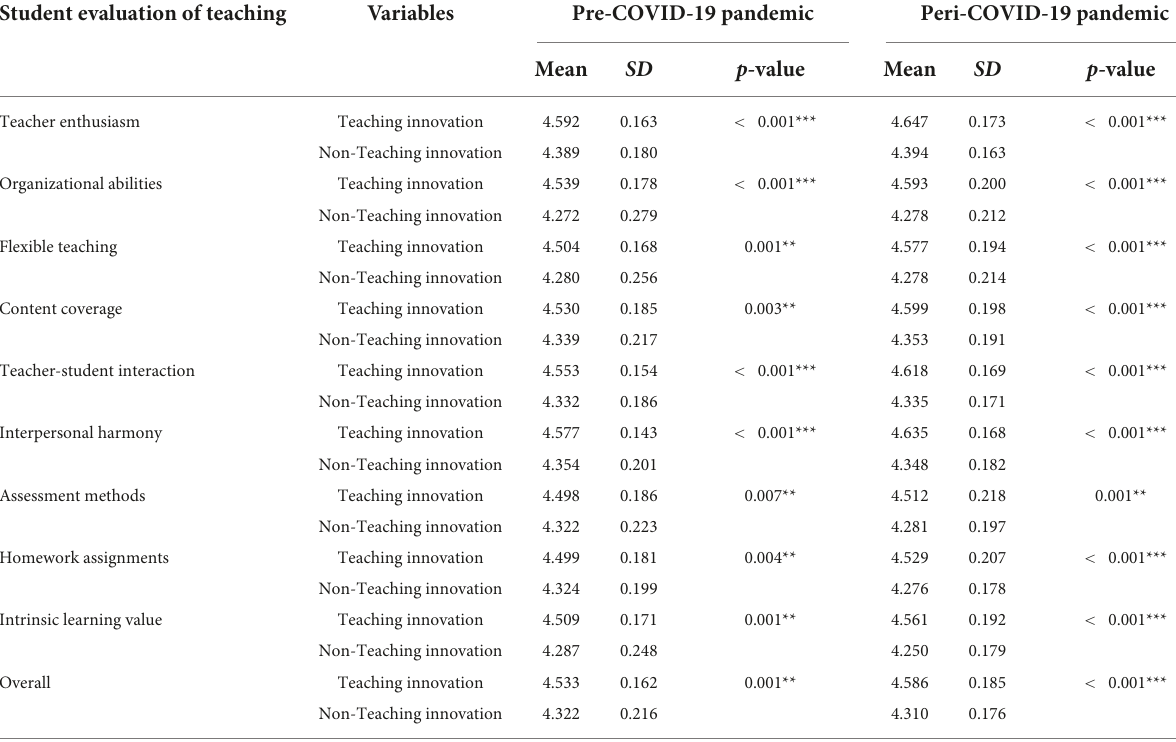
TABLE 3 Differences in SET of the teaching innovation and non-teaching innovation groups. Student evaluation of